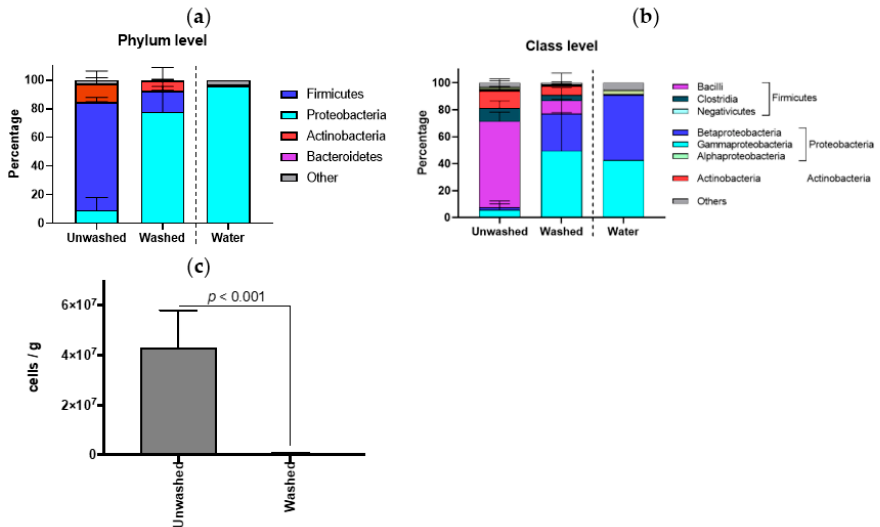
Figure 2. Compositions of bacteria in contaminated down and feather samples. Phylum ( a ) and class ( b ) level of the bacterial composition. n = 3, error bars indicate SD. Bacterial composition of each sample is depicted in Figures S2 and S3. ( c ) Quantification of contaminated bacterial in unwashed and washed samples. n = 3, error bars indicate